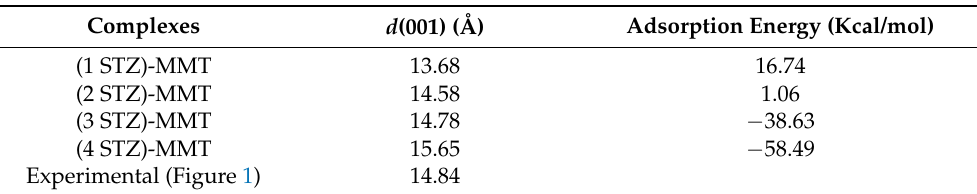
Calculated d (001) basal spacings and adsorption energies of the sulfathiazole- montmorillonite complexes.